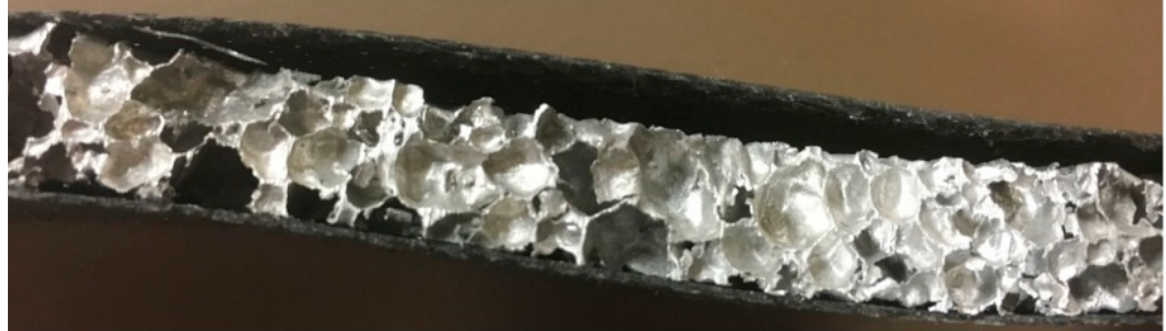
Figure 1. De-bonded AFS specimen subject to quasi-static load.